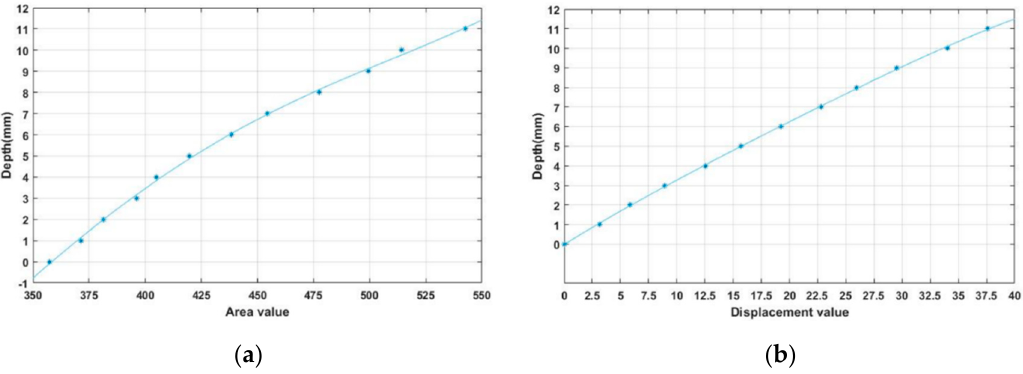
Figure 8. Area data along depth changes and its polynomial fitting ( a ) the result of third-order polynomial fitting to the area ( b ) the result of third-order polynomial fitting to the coordinate displacement.